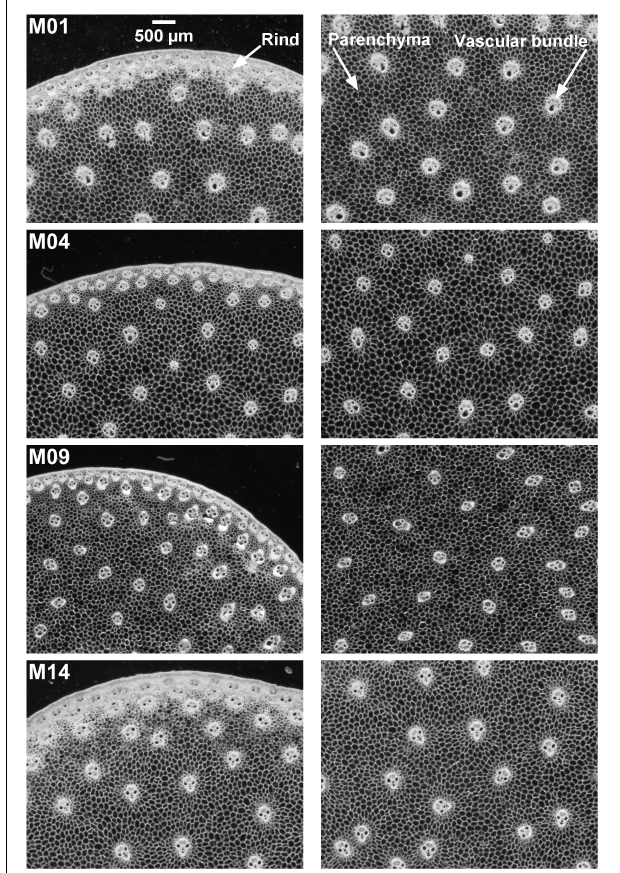
FIGURE 1 | BlueBox images. Example of inbred lines: individual fields of view of cross-sections. Fields of view: 5.92 × 4.43 mm 2 . Rind, parenchyma cells, vascular bundles are visible. Rind thickness and vascular bundle and cells size vary according to the inbred lines.